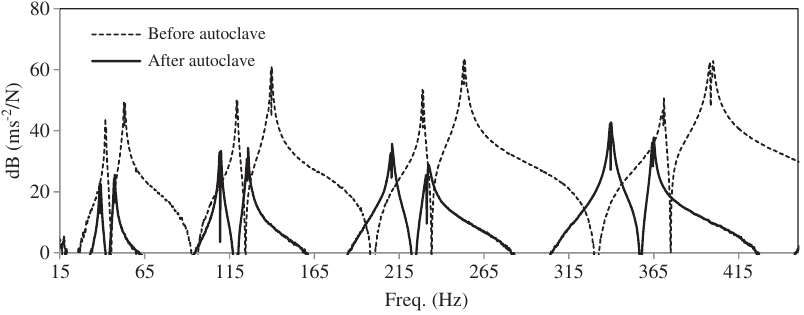
Figure 12: Comparison between FRF graphs for truncated cone # 2 before and after autoclave treatment.